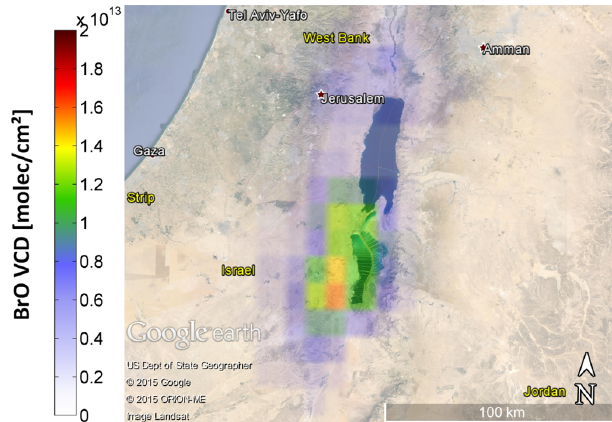
Figure 10. Averaged BrO VCDs over the Dead Sea as seen by OMI during summer months 2005–2014 (April–October). A clear BrO enhancement can be seen over the southern part of the Dead Sea, confirming former ground-based observations by Hebestreit et